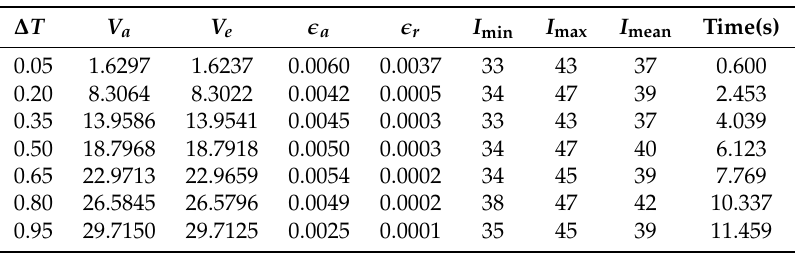
Table 1. Asynchronous parareal results with approximate option prices V a , exact option prices V e , absolute error (cid:101) a , relative error (cid:101) r and number of iterations I , given N = 20, m = 250, δ t = 0.001, S = 50, E = 60. ∆